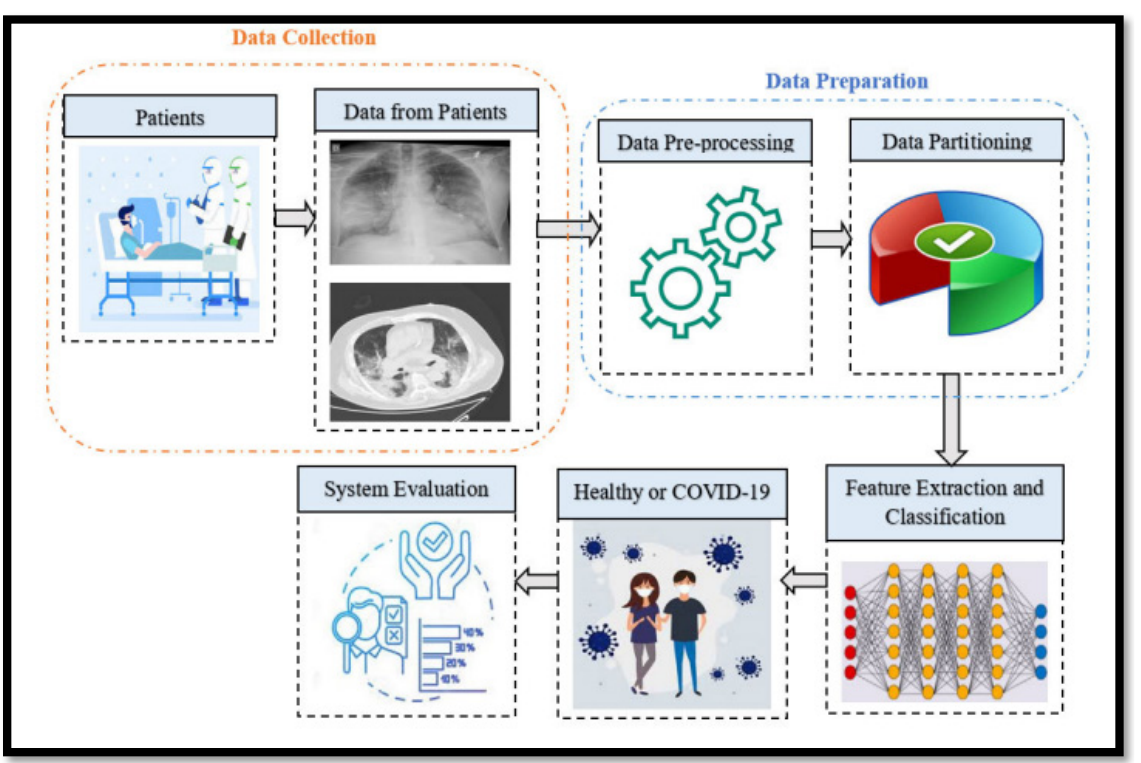
Figure 3. Data pre-processing of the evaluation of the result.